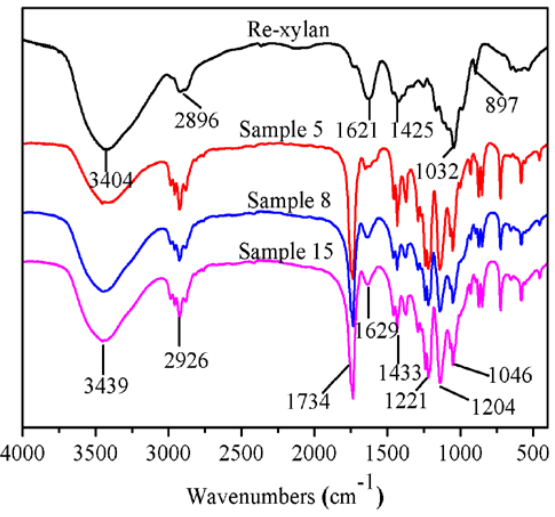
Figure 2. FT-IR spectra of regenerated xylan and xylan- g -PPDO copolymer samples 5 (WPG = 431.07%), 8 (WPG = 316.72%), and 15 (WPG =